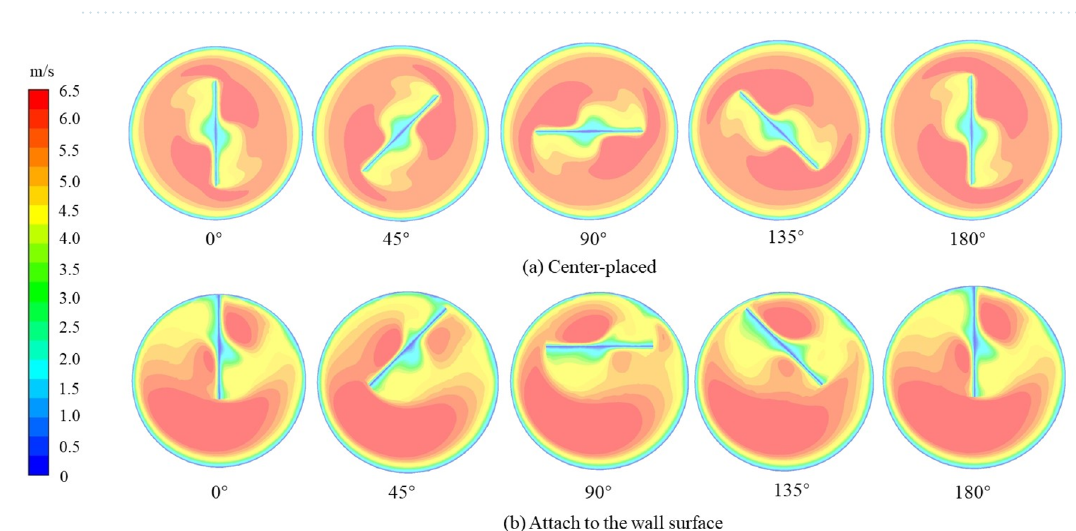
Figure 6. Comparison for velocity distribution in